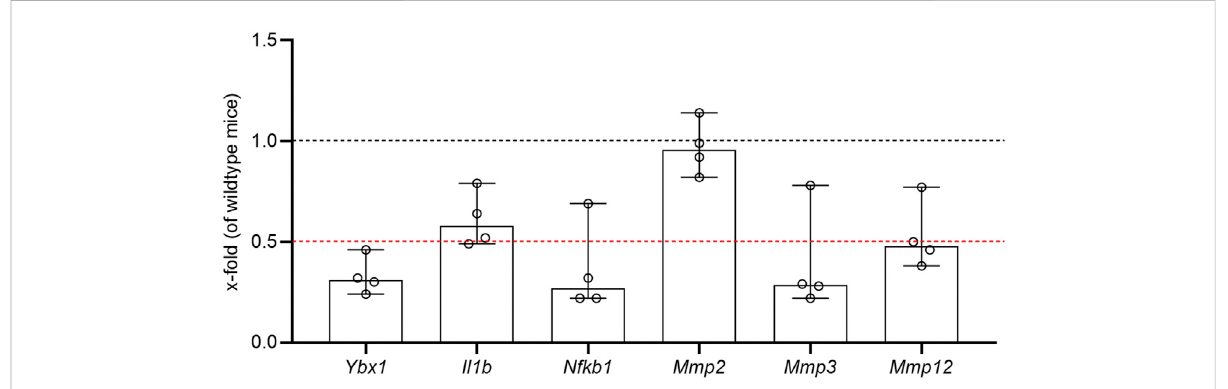
FIGURE 1 Transcriptionalanalysisofgenesrelatedtopregnancy.TheexpressionofindicatedgeneswasmeasuredbyRT-PCRinuterine/decidualtissueof heterozygous YB-1 and wildtype mice at GD14. The graphic shows the x-fold-expression of the heterozygous YB-1 mice in comparison to the wildtypegroupaccordingtoddCtmethod. n =4(formethoddetailsandprimersequencesseesupplementarymaterial). Ybx1 ,Y-boxbindingprotein 1 β ; Il1b , interleukin beta; Nfkb1 , nuclear factor kappa-light-chain-enhancer of activated B cells subunit 1; Mmp2/3/12 ; matrix metallopeptidase